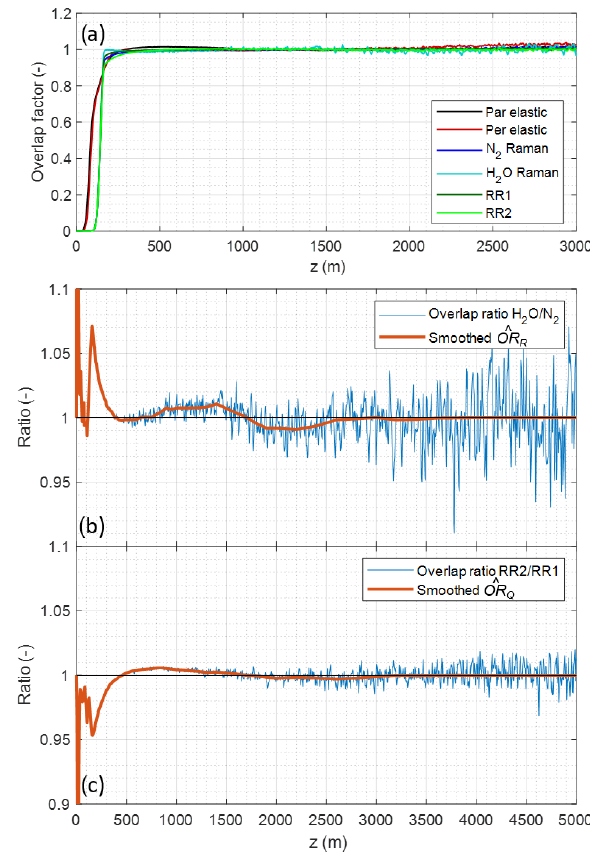
Figure 11. (a) Overlap factors measured over 3h of nighttime mea- surements with a horizontal line of sight on 19 December 2019. Es- timated overlap ratios between VR (b) and RR (c) channels: native resolution (thin blue line) and final estimate after smoothing (thick red